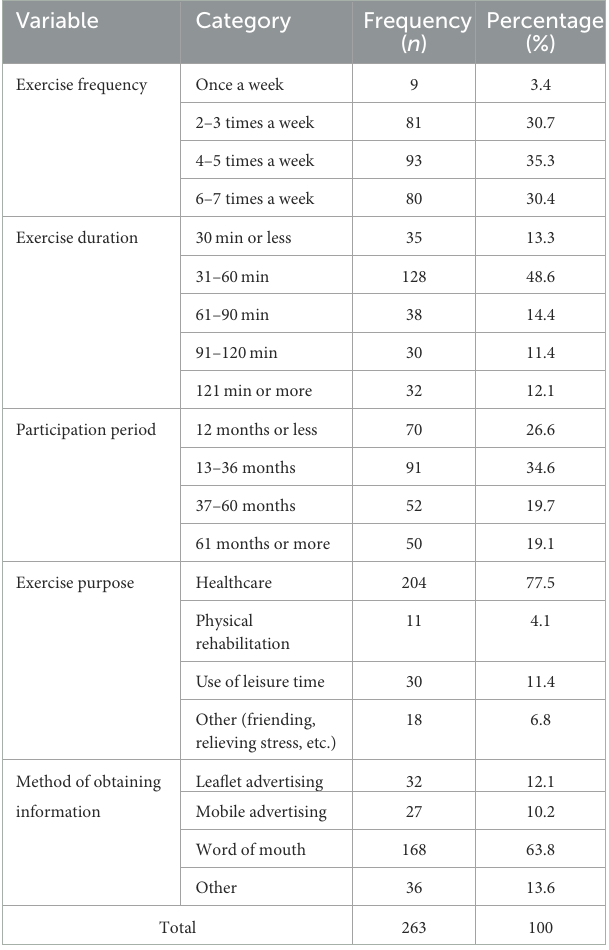
TABLE 3 Respondents’ exercise participation